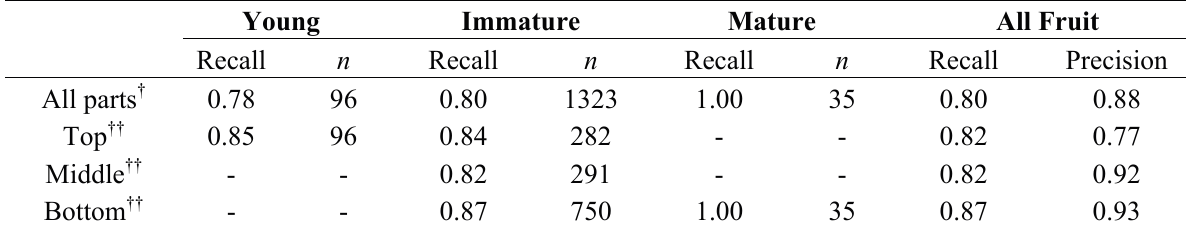
Table 1. Results of fruit detection using the developed method.